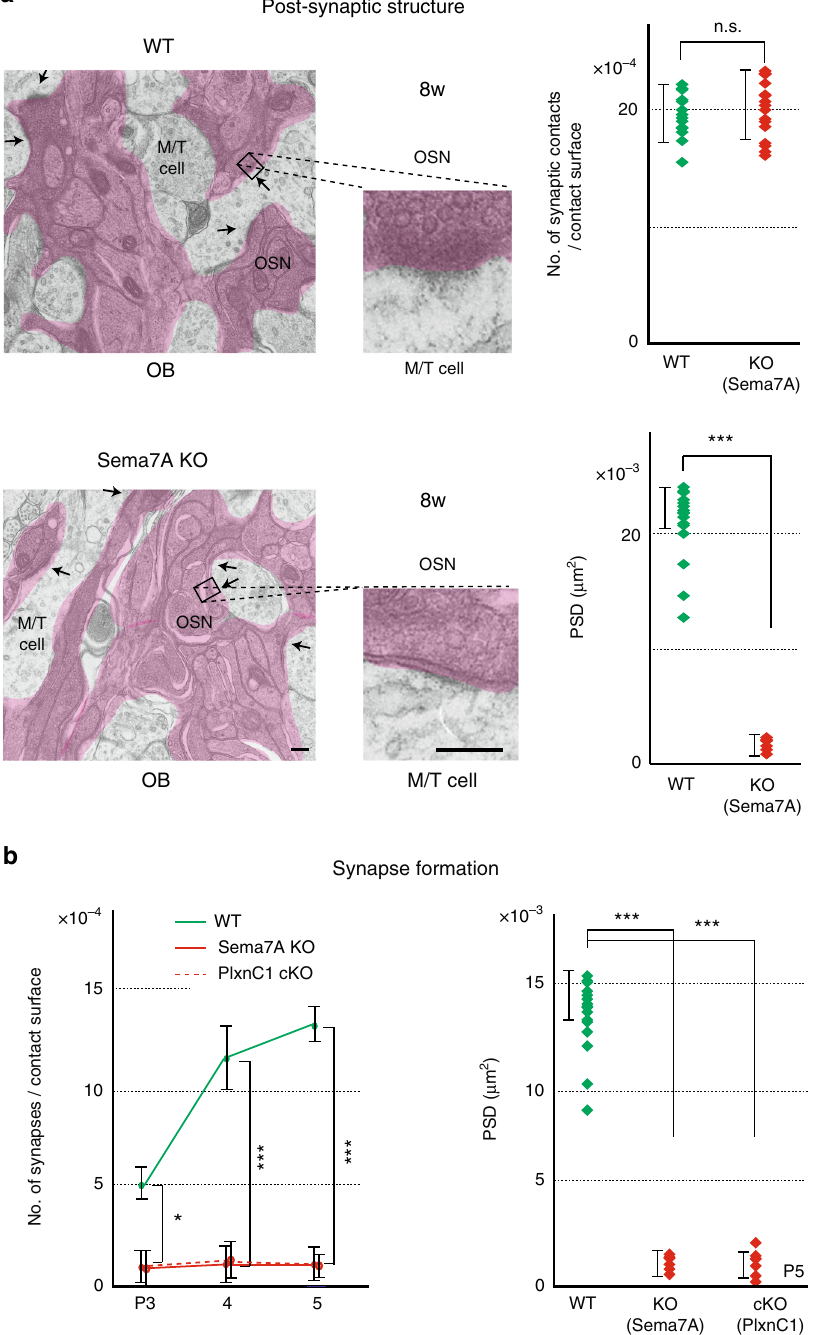
Fig. 5 Synapse formation in the KOs of Sema7A/PlxnC1 signaling. a EM analysis of post-synaptic structures. Synaptic contacts and post-synaptic structures were analyzed in the 8w WT, and Sema7A total KO by electron microscopy (EM). Arrows indicate synaptic contacts. Enlarged views demonstrate that only the surface attachment, but not mature PSD, is formed in the KO. *** p < 0.005 (Student ’ s t -test). n.s., not signi fi cant. Error bars indicate SD ( n = 3, 4 animals). Scale bars = 300 nm. b The numbers of synaptic structures are compared among the WT, Sema7A total KO, and PlxnC1 cKO in neonatal stages by electron microscopy (left). * p < 0.05, *** p < 0.005 (Student ’ s t -test). Error bars indicate SD ( n = 2, 2, 5 animals for each line). The areas of PSD at P5 are also compared (right). *** p < 0.005 (Student ’ s t -test). Error bars indicate SD ( n = 6, 5, 6